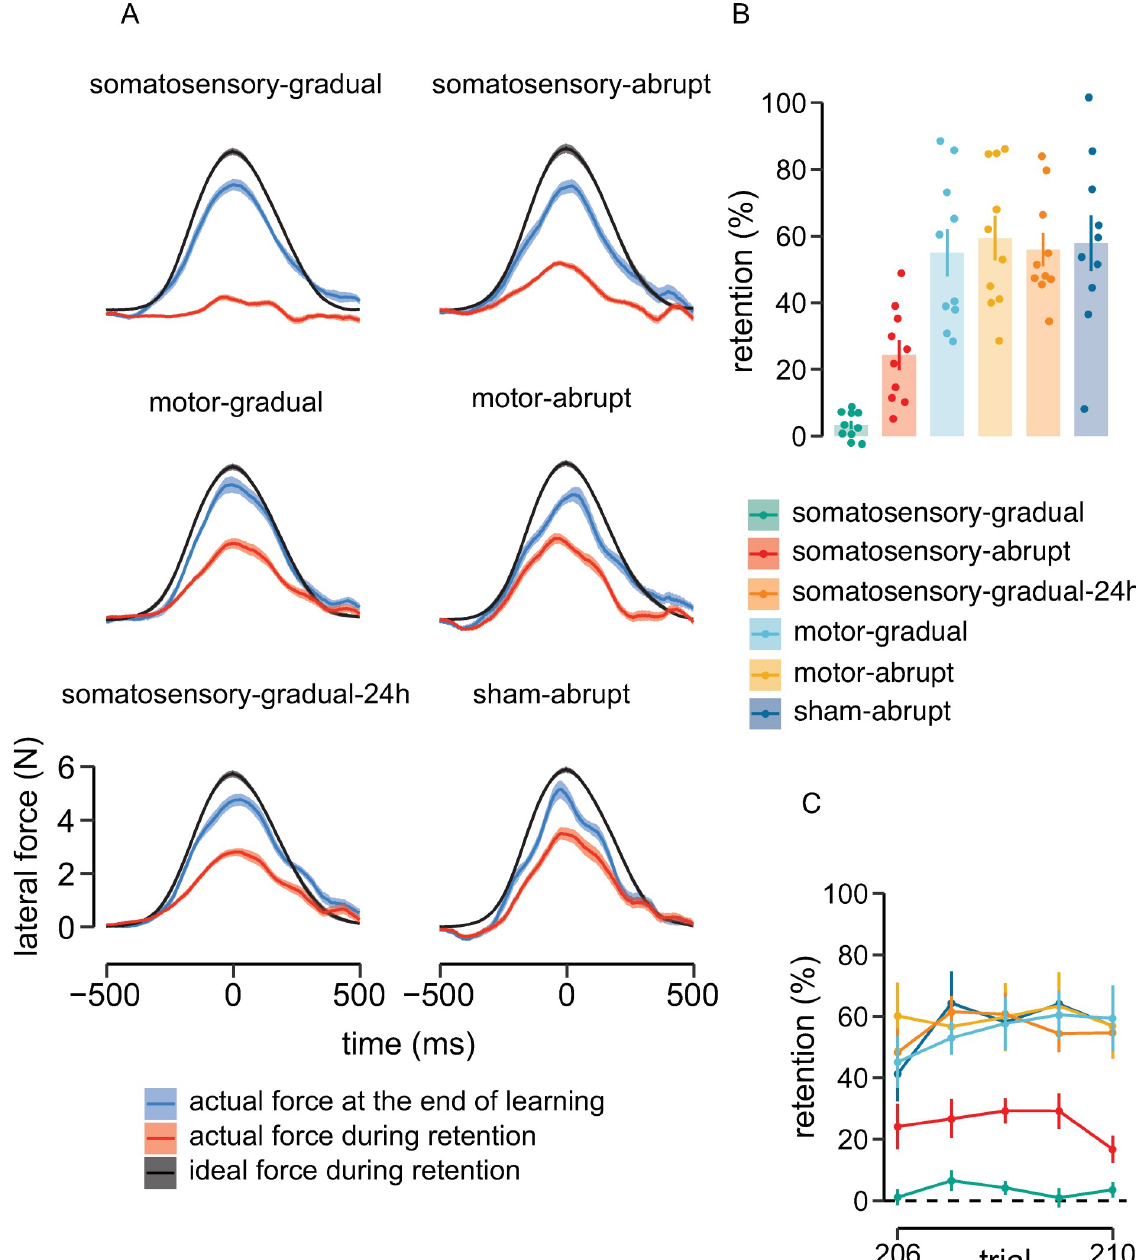
Fig 3. Suppression of somatosensory cortex using cTBS disrupts the consolidation of motor memory. (A) Mean force profiles (in red) produced by participants in each group during error-clamp trials in a retention session 24 hours after initial training. The force profile in black represents the expected force profile if participants showed full retention of initial learning. The force profile in blue is the actual force produced at the end of initial learning. When loads were introduced gradually (to engage implicit learning mechanisms), suppression of somatosensory cortex (somatosensory-gradual) completely eliminated retention as indicated by near-zero force levels in the retention test. When loads were introduced abruptly (somatosensory-abrupt), in order to engage both explicit and implicit mechanisms, cTBS to somatosensory cortex led to partial retention. cTBS did not interfere with consolidation when applied to motor cortex after learning either with a gradual (motor-gradual) or abrupt (motor-abrupt) onset of perturbation. Participants in these conditions produced forces comparable to those in the sham condition. The suppression of somatosensory cortex 24 hours after consolidation of initial learning (somatosensory- gradual-24h) had no effect on retention (forces were comparable to those in the sham condition), which indicates that cTBS to somatosensory cortex does not block the retrieval of previously consolidated memories. (B) Percent retention (amount of retention after 24 hours divided by the amount of adaptation at the end of initial training) assessed through error-clamp trials. Dots represent the mean retention (5 trials) for